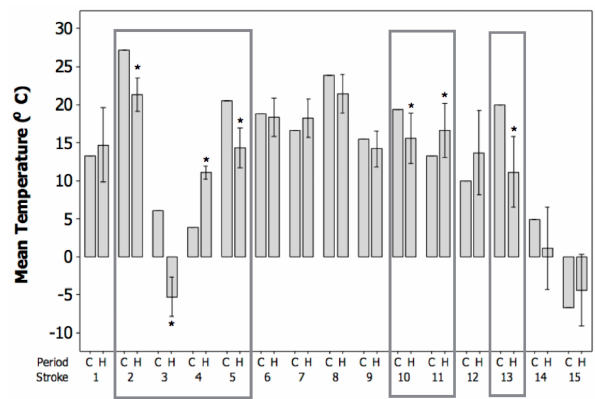
Figure 2. Mean temperature (°C) in the control periods (C) and the mean temperature ±95% CI in the 7-day hazard periods (H) before the canine strokes (n = 15). Significant effects (* p < 0.05) are displayed within boxes.